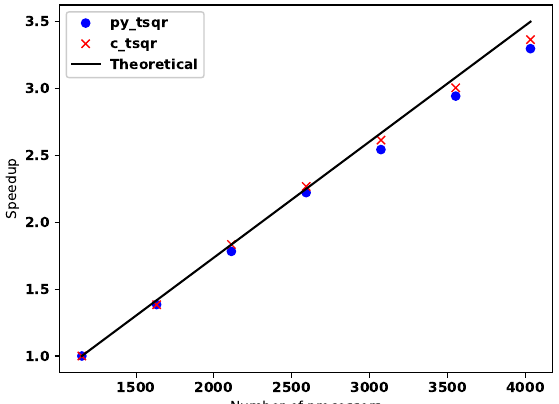
Figure 3. Scalability of the single-value decomposition algorithm (most computationally demanding part of POD) for the Python and Cython versions.